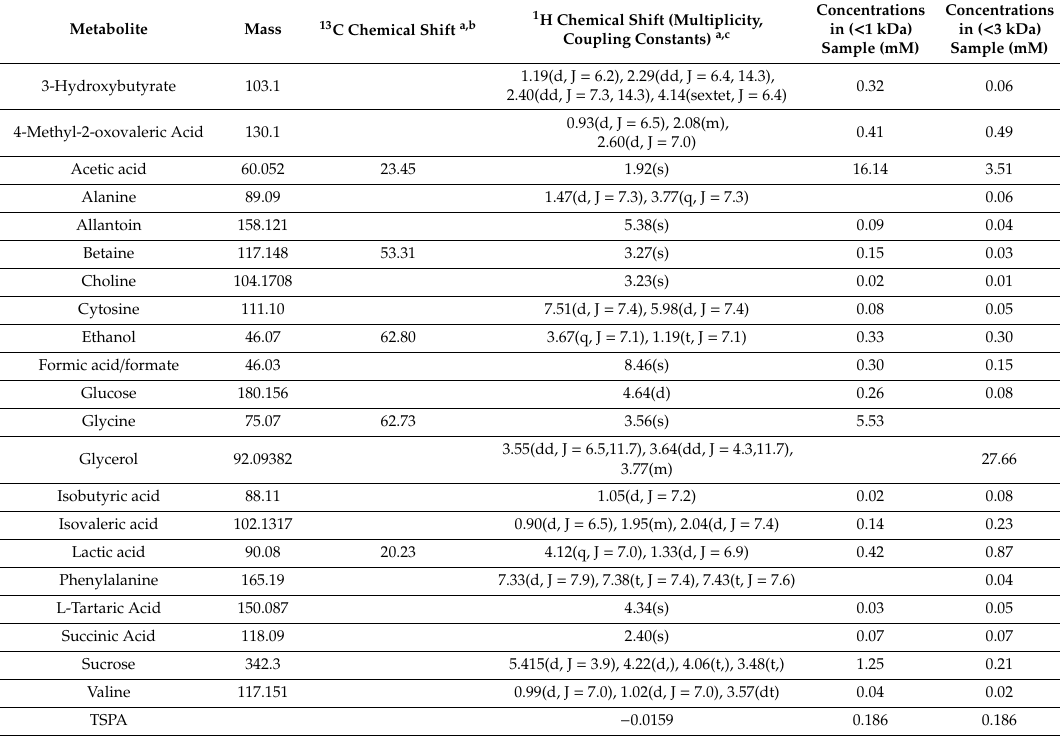
Table 1. List of the metabolites identified by NMR in lyophilized mucus from Helix aspersa , reported as the average from 3 controls.